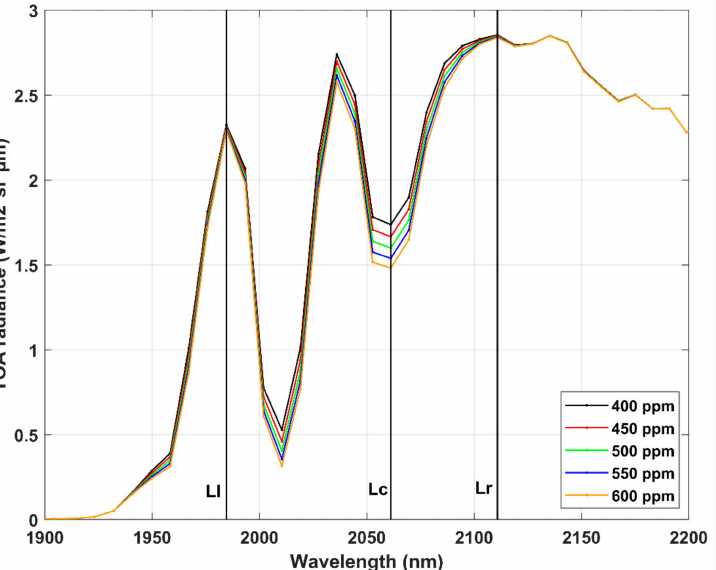
Figure 2. Simulated TOA spectral profiles convolved on PRISMA channels for several CO 2 column- averaged values (400, 450, 500, 550, 600 ppm) and the standard H 2 O column amount corresponding to 1.416 g/m 2 (US standard